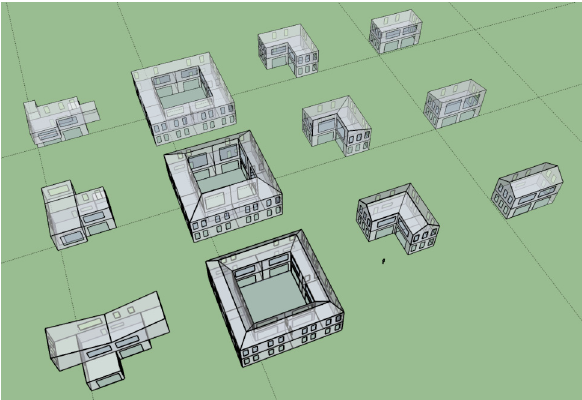
Figure 1: Exploring the design space of the “residential” build- ings: static reference models created with conventional modeling software (Google SketchUp) served as guideline for abstraction.